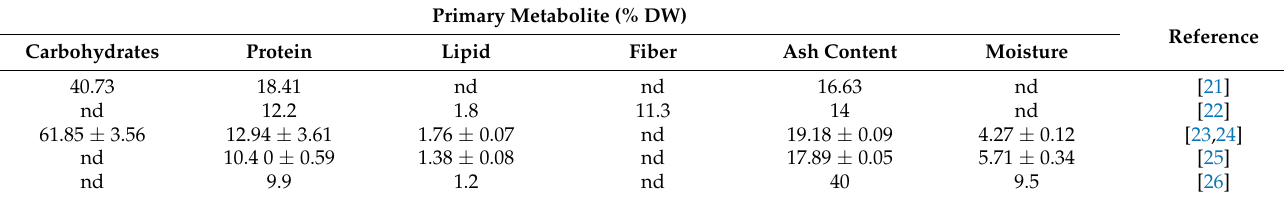
Figure 3. Current research trends of the pharmacological properties of H. fusiformis. Table 1. Proximate composition of H. fusiformis